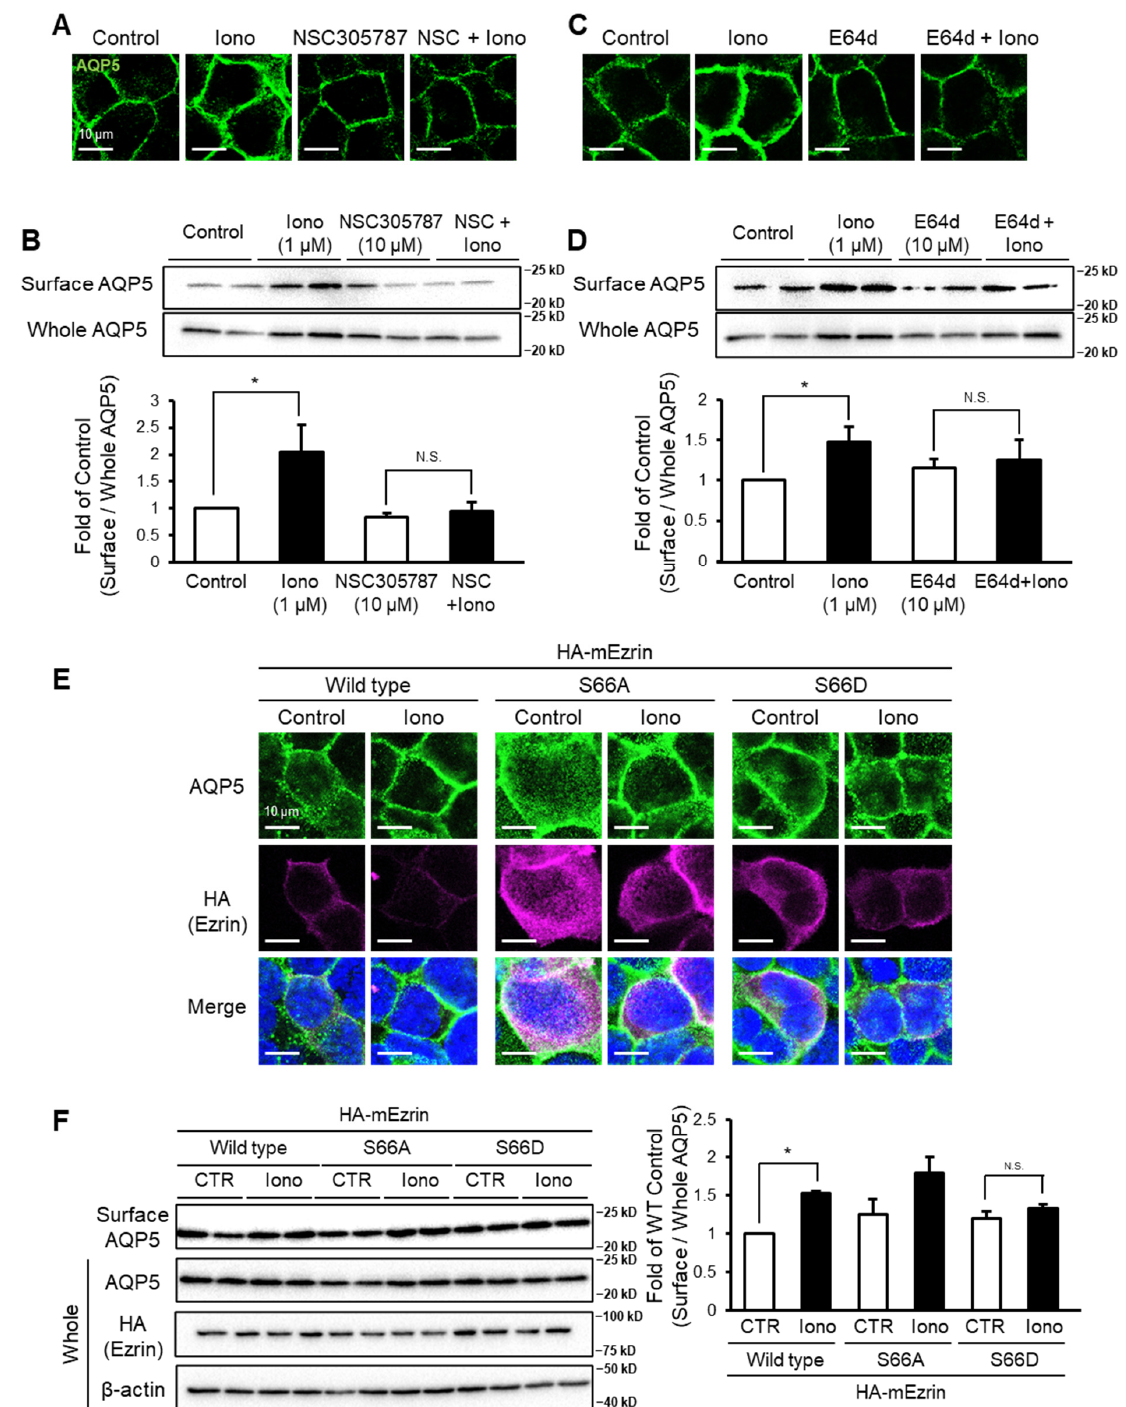
Figure 2. Ezrin inhibition decreases stimulation-dependent membrane trafficking. MLE-12 cells were treated with ionomycin (1 µM) and NSC305787 (10 µM) for 15 min. Subcellular localization of AQP5 was analyzed by immunofluorescence ( A ).